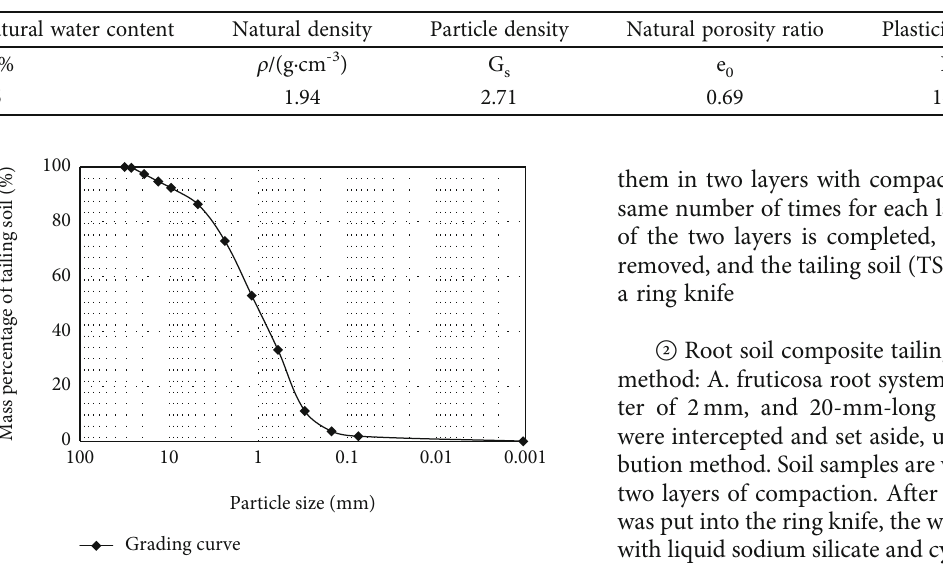
Table 1: Basic physical parameters of tailing soil.